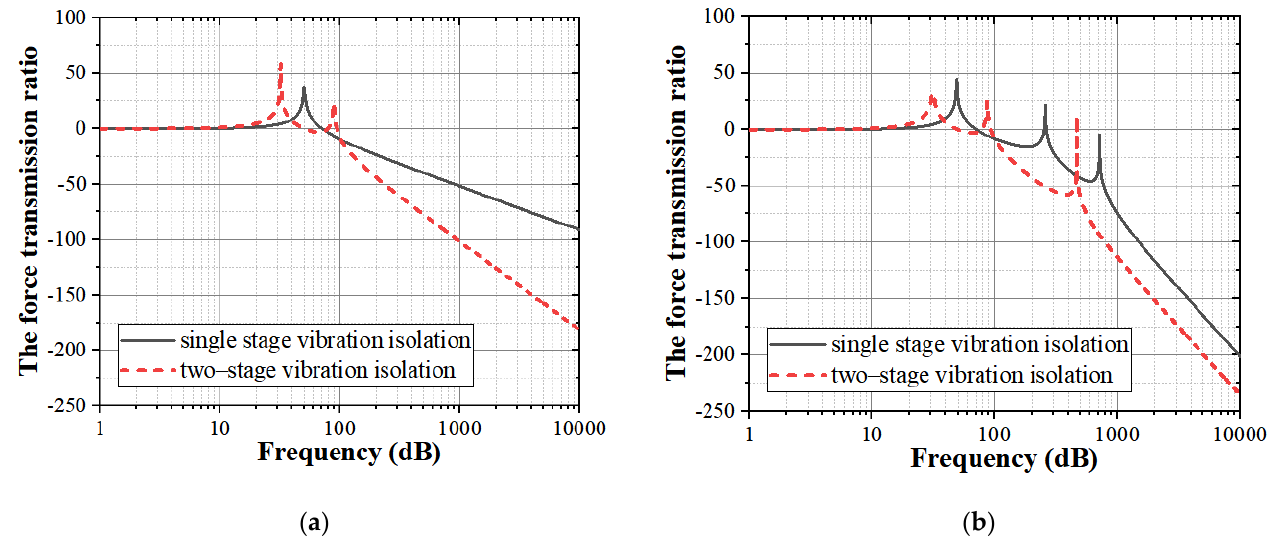
Figure 6. The force transmission ratios of the single- and two-stage vibration isolation: ( a ) without considering the structure stiffness; ( b ) considering the structure stiffness.